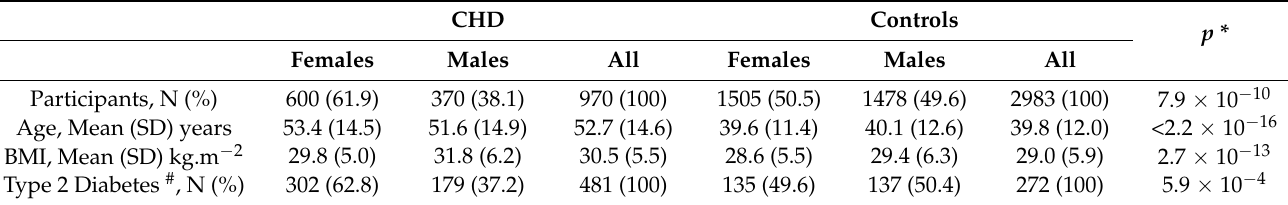
Table 2. The cohort characteristics after the quality control